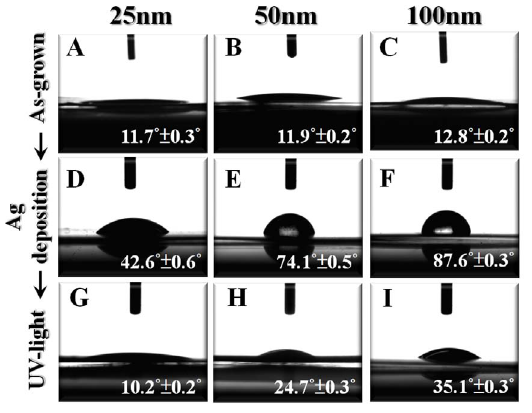
Figure 5. Cumulative Ag release profiles from the 25- and 100- nm-diameter Ag-decorated nanotubes into PBS. There were no statistical differences among the Ag-decorated samples with regards to the nanotube diameter ( p . 0.05 ). Data were means 6 SE of three independent experiments.